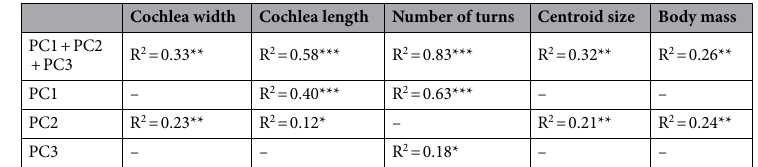
Table 2. PGLS regression values between shape variables and several morphological measurements. Significance level: * P < 0.05; ** P < 0.01; *** P <